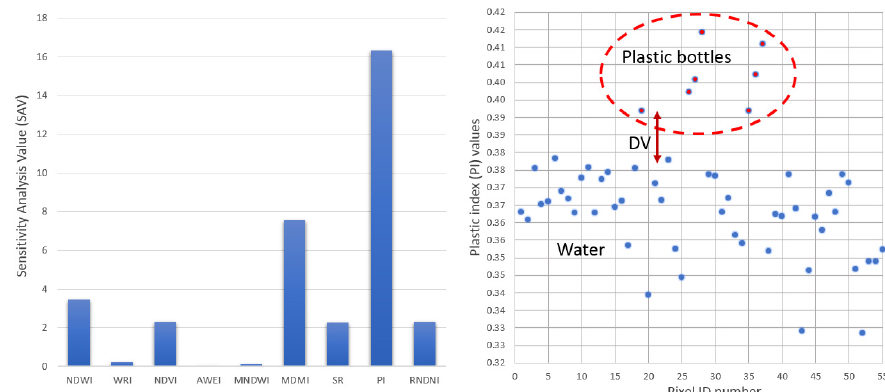
Figure 10. Left : results of the sensitivity analysis in bar graph for each of the nine indices. Right : Plastic Index (PI) scatterplot showing the discriminating value (DV) between water and plastic bottles. The plastic bottles values are circled in